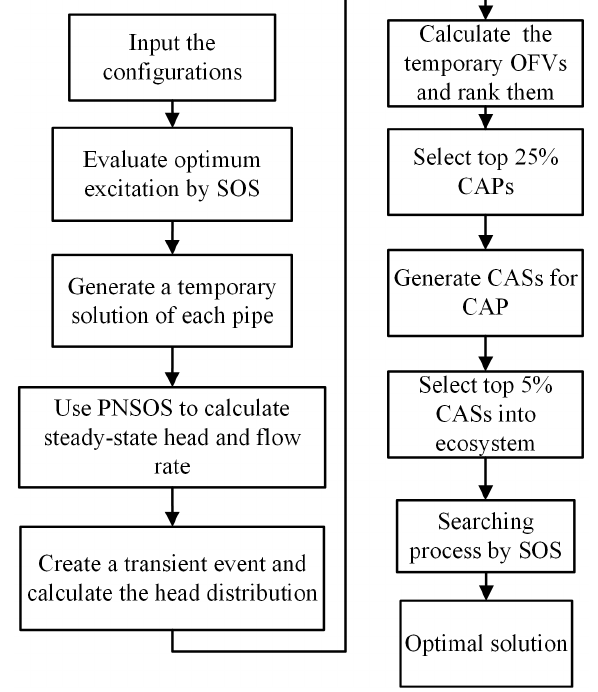
Figure 4. Flowchart of leak detection ordinal symbiotic organism search (LDOSOS).